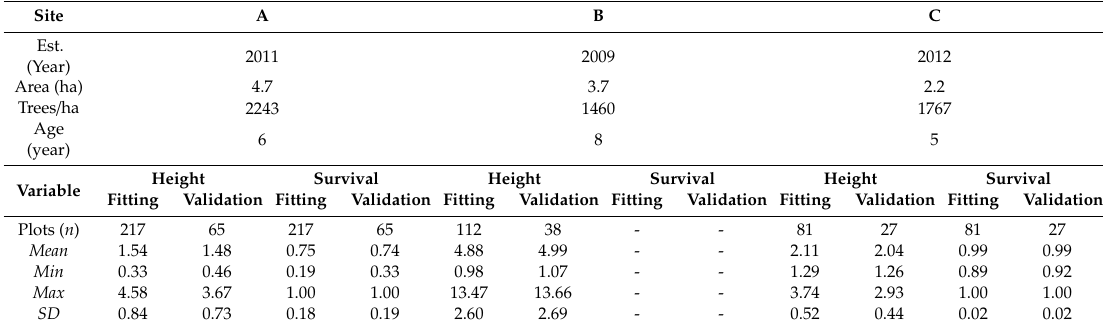
Table 1. Summary of the experimental site inventory data.